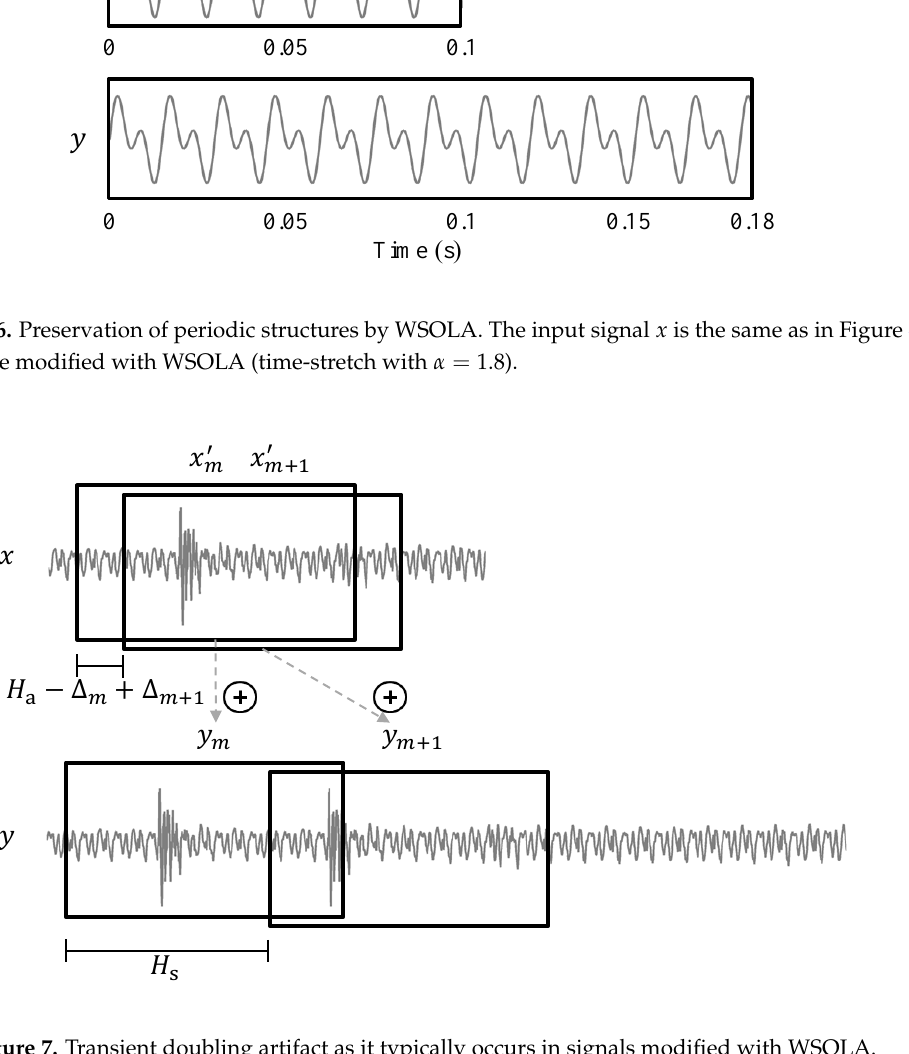
Figure 7. Transient doubling artifact as it typically occurs in signals modified with